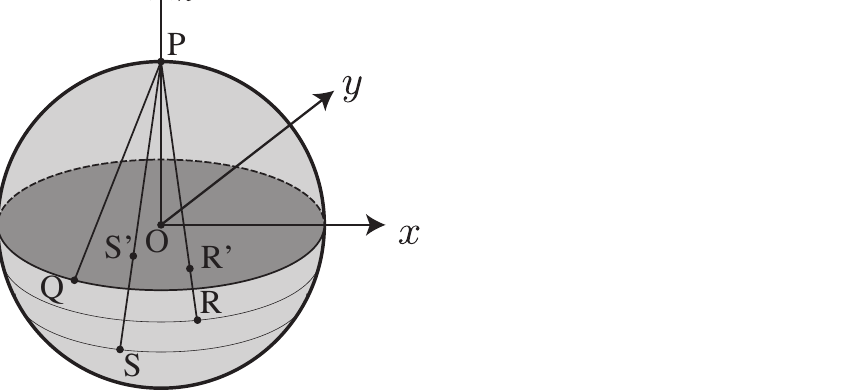
Figure 7. Schematic illustration of a stereographic projection of a spherical